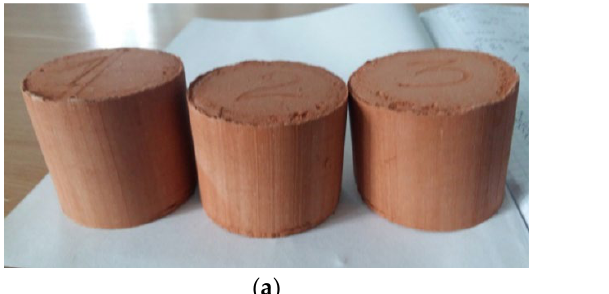
Table 8. Physical and mechanical properties of fired samples. Figure 7. Fired samples at 950 °C. ( a ) Sample with loam; ( b ) sample with 25% addition of waste Figure 7. Fired samples at 950 ◦ C. ( a ) Sample with loam; ( b ) sample with 25% addition of waste sorbent. sorbent.